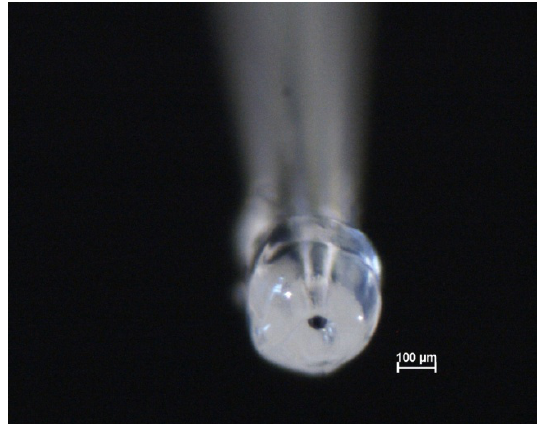
Figure 9. Optical image of a microcapillary with a silicone